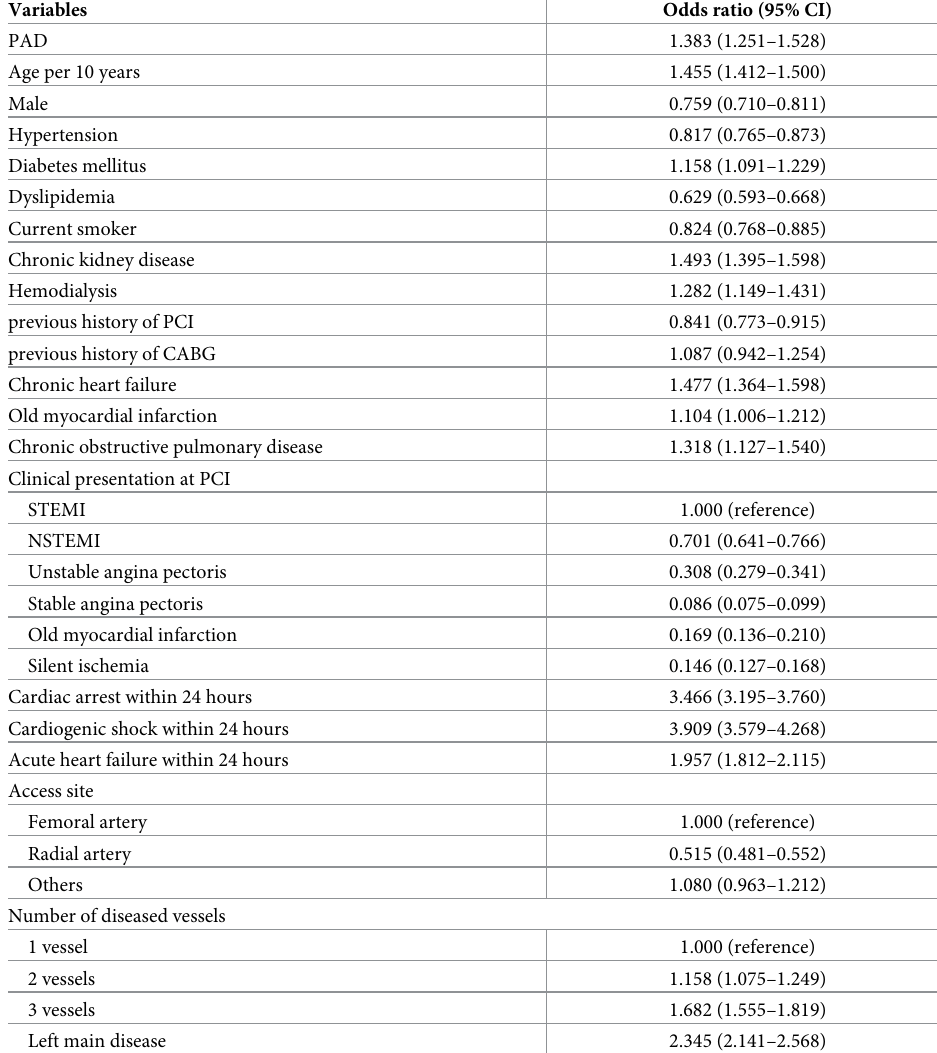
Table 4. Multivariate logistic regression analysis for in-hospital